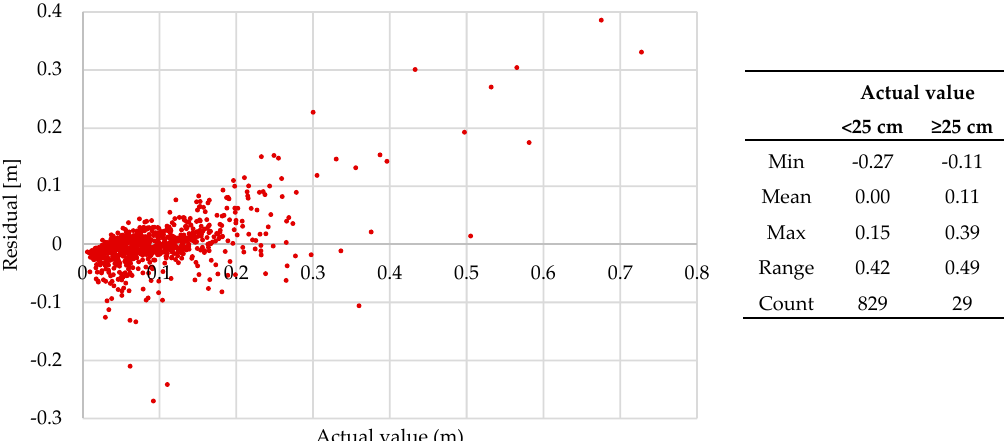
Figure 11. Residual plot of predicted values against the actual value (Model 8, test data). The table shows the minimum, mean and maximum residual, as grouped by the actual value.